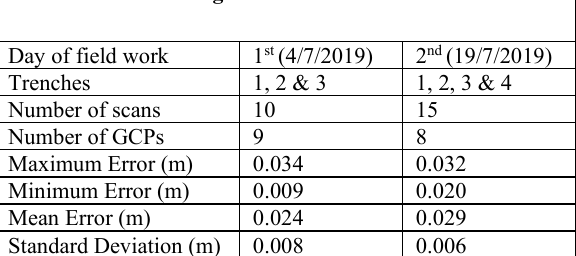
Table 2 . Model Georeferencing results using the PolyWorks Inspector software.